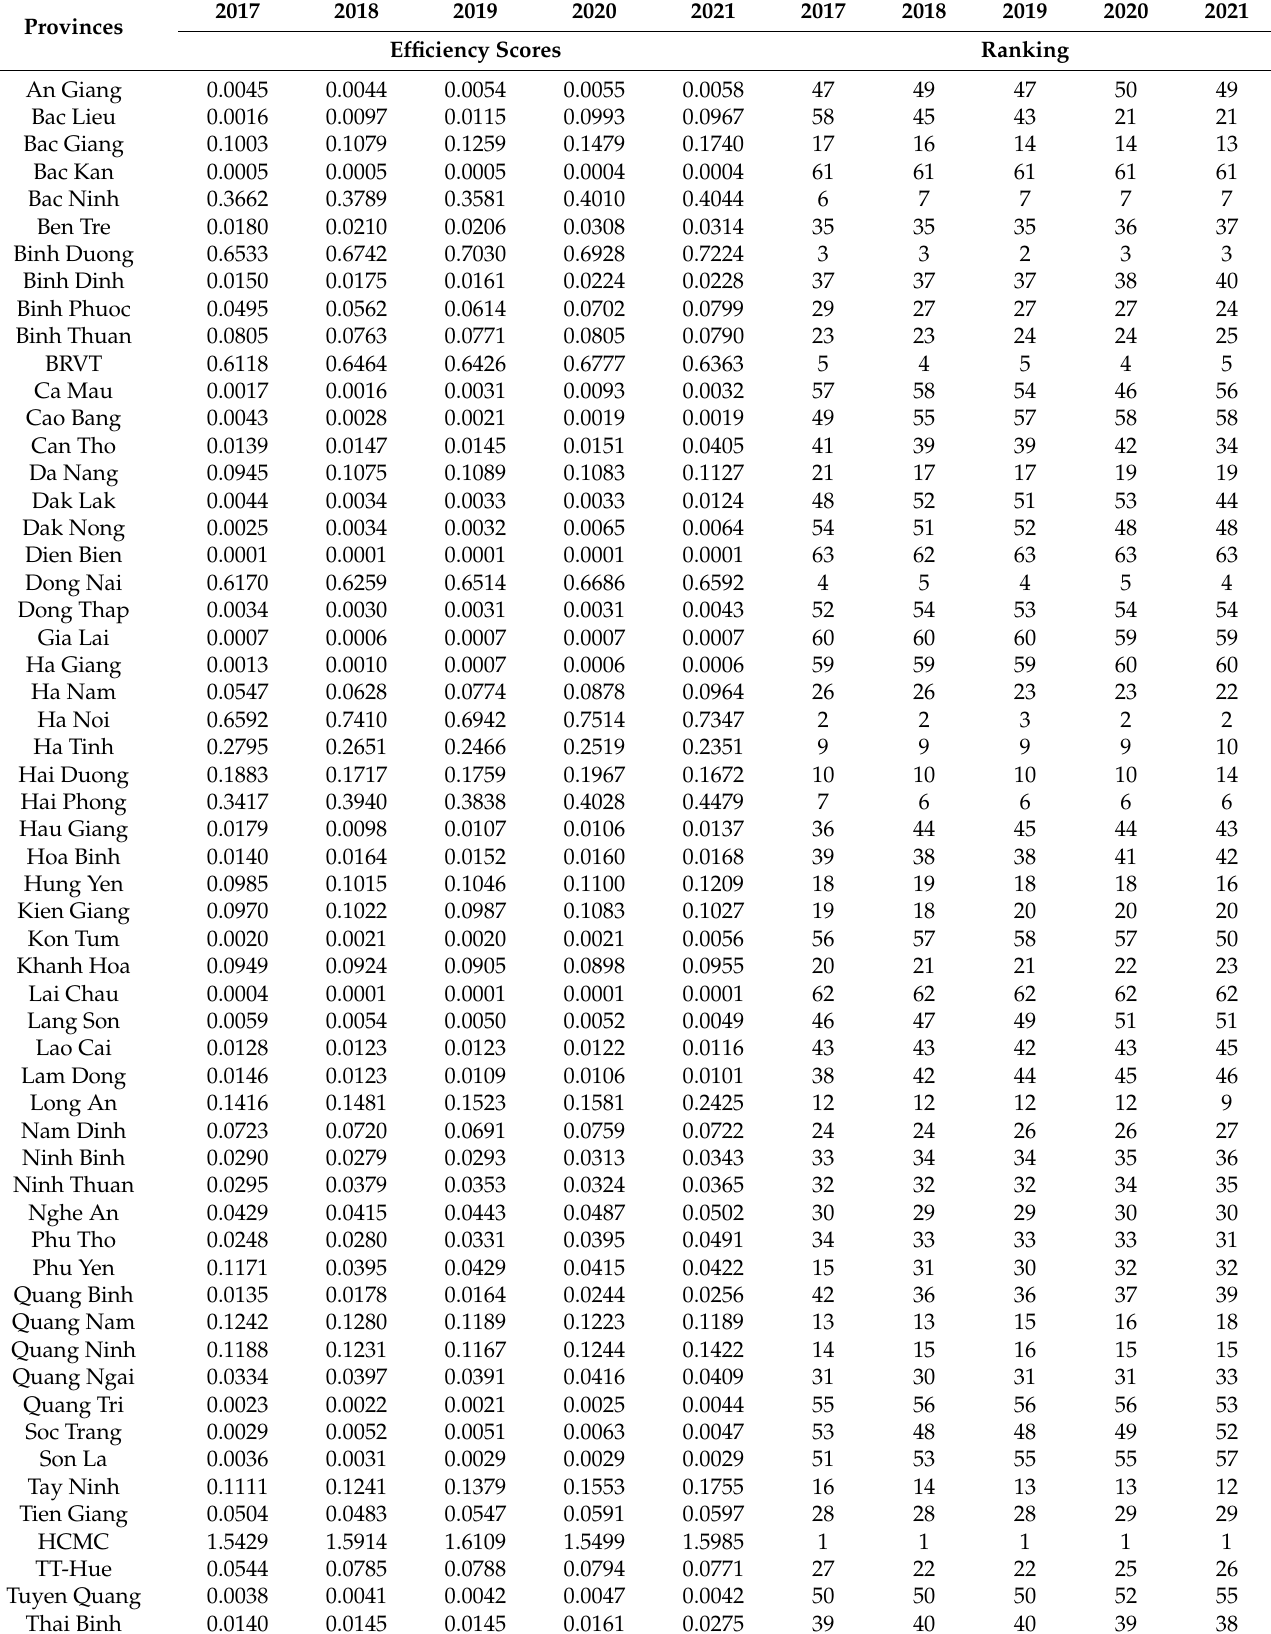
Table 5. FDI attractiveness efficiency scores and ranking of provinces